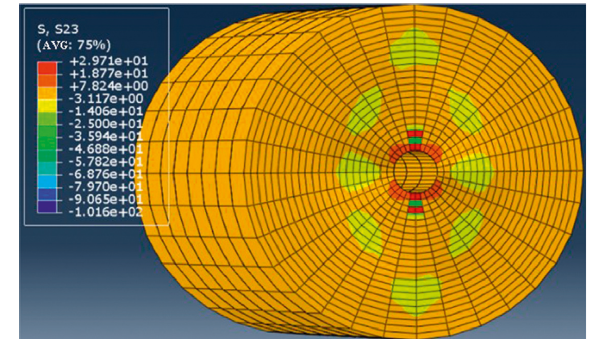
Figure 29: Stress cloud of intermediate layer S23 in 400% com- pression shear condition.